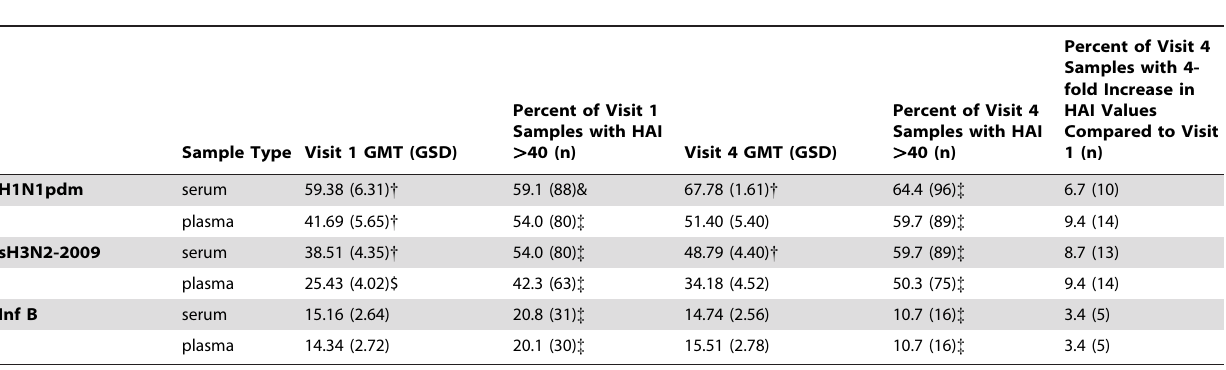
Table 2. Comparison of HAI data from Visit 1 (acute phase of ILI-symptoms) and Visit 4 (convalescent phase of ILI-symptoms) for 149 paired serum-heparinized plasma samples for three influenza viruses.